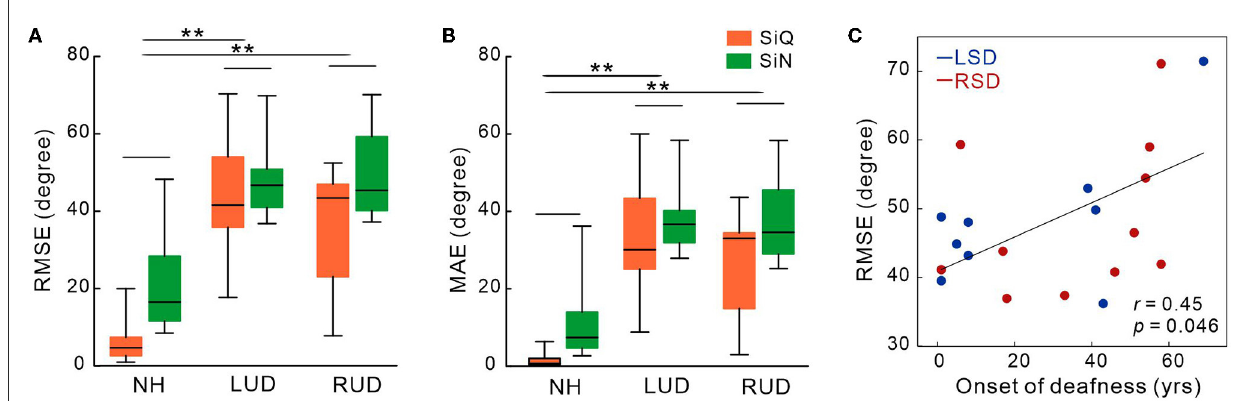
FIGURE2 Mean root-mean-square error (A) and mean absolute error in degree (B) in subject groups with normal-hearing and with left- and right-sided deafness during the speech-in-quiet and speech-in-noise listening conditions. (C) The root-mean-square error correlations with the onset of deafness in SSD groups. Error bars: the standard error of the mean. RSD, right-sided single-sided deafness; LSD, left-sided single-sided deafness; NH, normal hearing; SiN, speech-in-noise; SiQ, speech-in-quiet; RMES, root-mean-square error; MAE, mean absolute error. ** P <